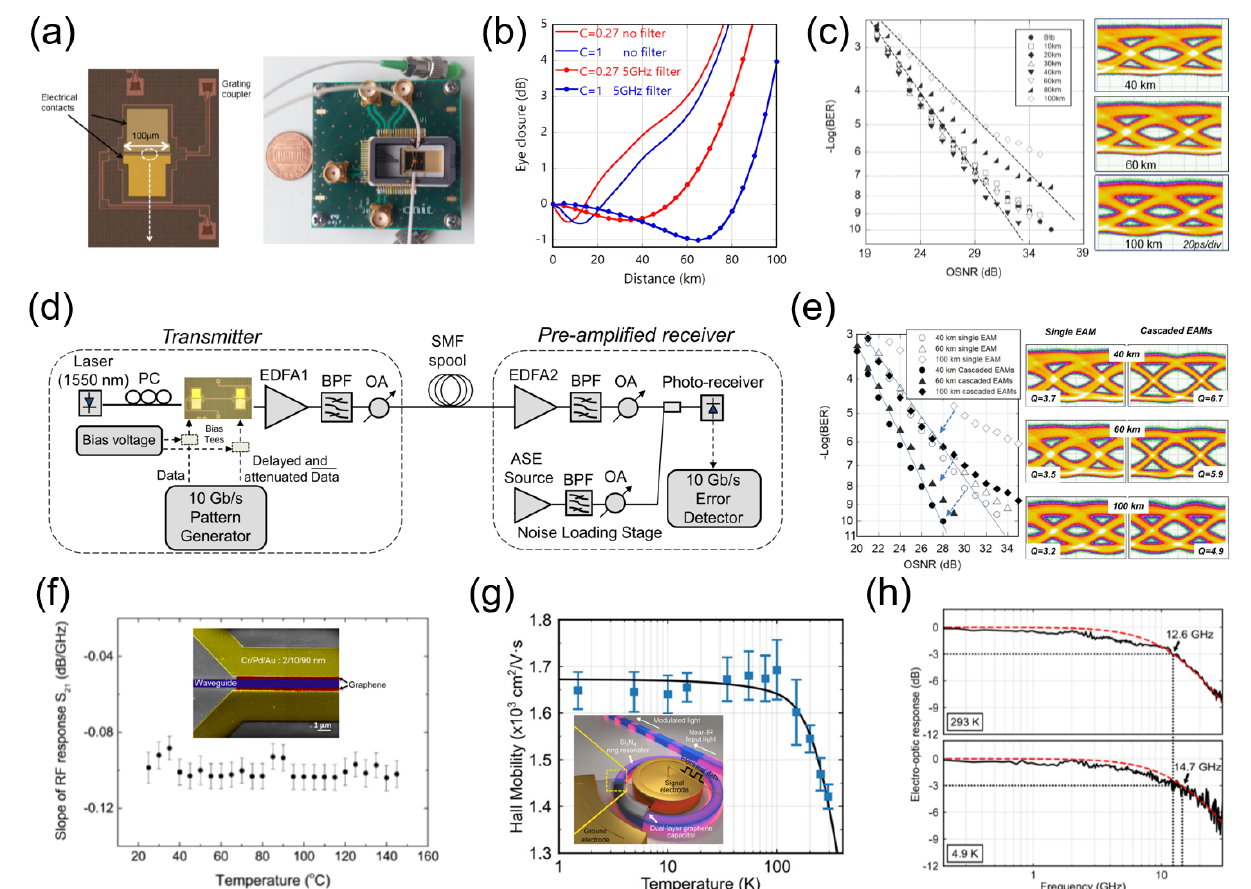
Figure 4. Graphene − based EO modulators towards practical communication scenarios. ( a ) Optical microscope image of the device and picture of a packaged EAM sample [58]. Reproduced from Ref. [58] with permission. ( b ) Eye closure penalty for NRZ transmission at 10 Gbps over standard SMF for different values of the pre-chirp parameter C [58]. Reproduced from Ref. [58] with permission. ( c ) BER curves versus OSNR and the open-eye diagrams for transmission distances up to 100 km to verify the dispersion compensation properties of graphene EA modulators. The insets show sample transmitted eye diagrams [58]. ( d , e ) The setup for testing the cascaded graphene EA modulators using optical pre-emphsis. Single and cascaded graphene EAM transmitter BER versus OSNR at 40, 60 and 100 km with correspondent eye diagrams [59]. Reproduced from Ref. [59] with permission. ( f ) Robust athermal operation of the graphene modulator under a wide temperature range. Inset: optical microscope image [56]. Reproduced from Ref. [56] with permission. ( g ) Graphene mobility using a Hall bar with respect to temperature [60]. Reproduced from Ref. [60] with permission. ( h ) Electro- optic responses of graphene modulator at cryogenic temperature and room temperature